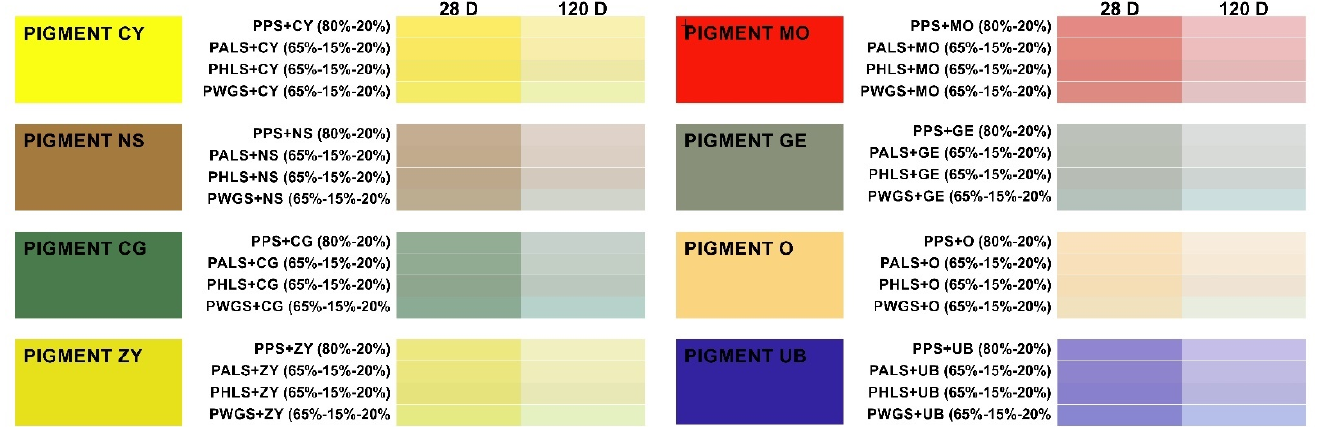
Figure 7. Color chart for the different mixes and inorganic pigments used, with an indication of their color code for both of the test phases (28 days and 120 days).